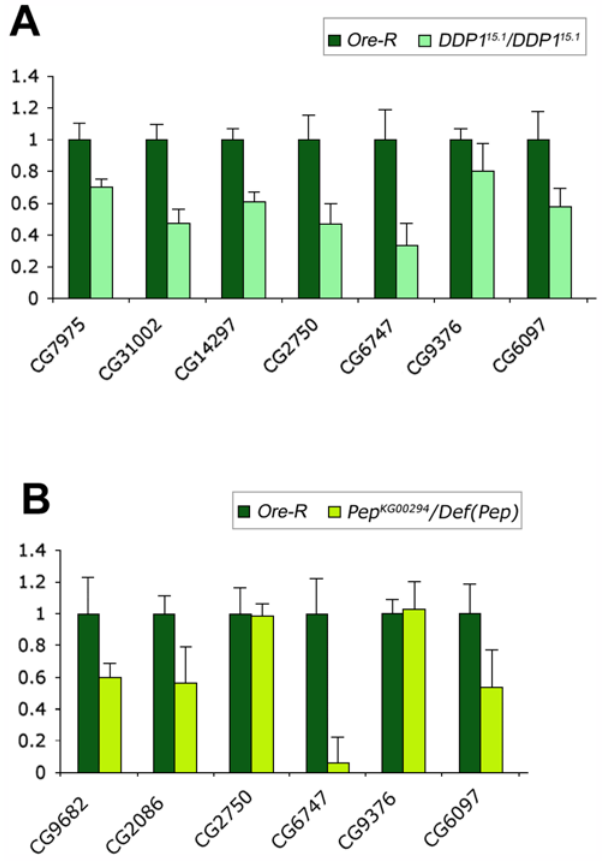
Figure 6. Genes corresponding to transcript targets of HP1a in S2 cells appear down-regulated also in DDP1 and PEP mutants larvae. (A) Quantitative RT–PCR analysis of the expression in wild type Ore-R and DDP1 mutant larvae showing a significant decrease in the amount of the transcripts corresponding to all genes. (B) Quantitative RT–PCR analysis in wild type Ore-R and PEP mutant larvae. In this case a significant decrease in the amount of the transcripts is evident for four of the six analyzed